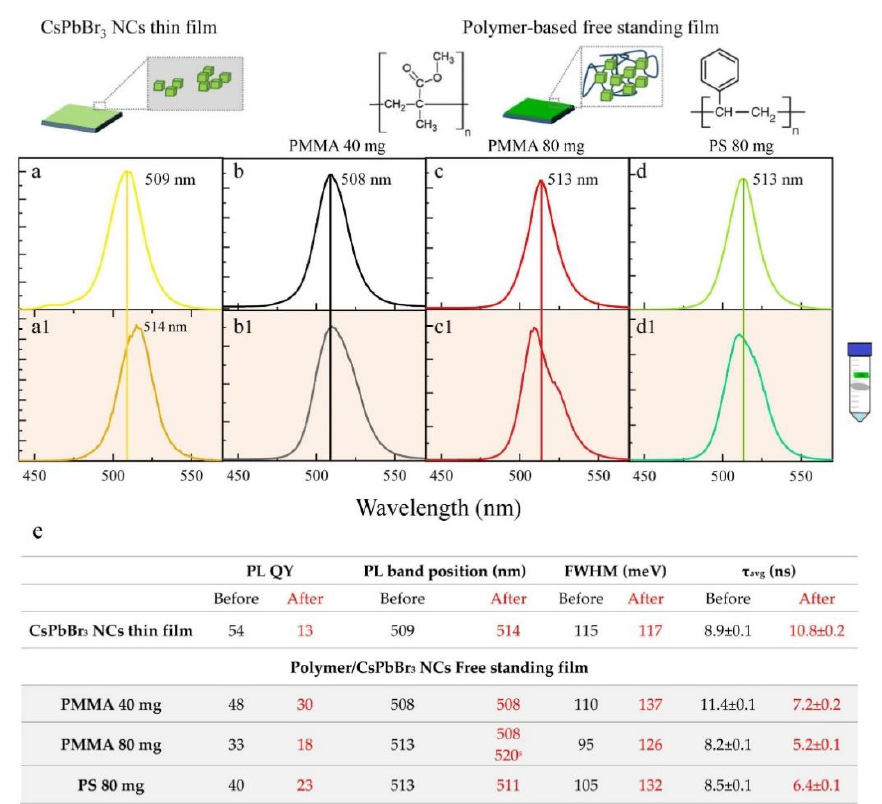
Figure 3. Steady-state fluorescent spectra ( λ ex = 375 nm) of NCs thin film ( a , a1 ) and free-standing films prepared at PMMA 40 mg ( b , b1 ), 80 mg ( c , c1 ) and PS 80 mg ( d , d1 ) and fixed CsPbBr 3